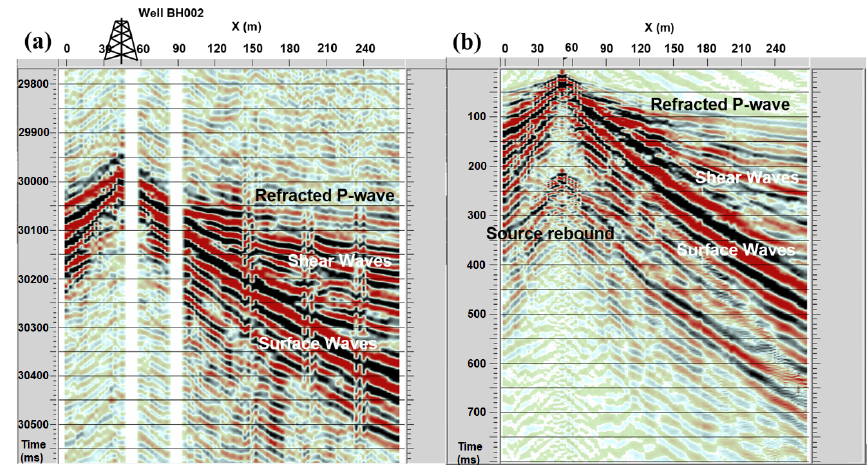
Figure 4. (a) The results of interferometry by deconvolution of the raw data at the location of well BH002 against the active source gathering recorded at the same location (b) . Note the weight drop source rebound energy recorded in (b)